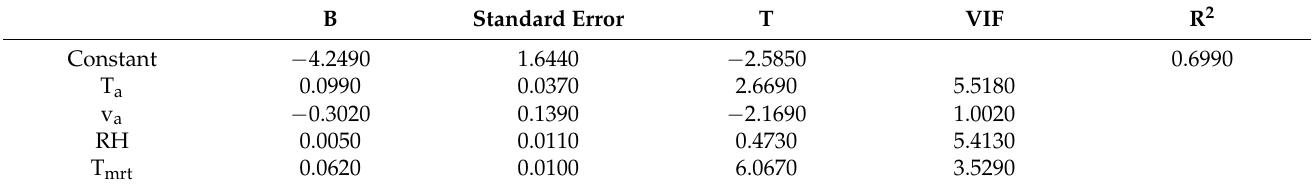
Table 4. Regression coefficient of the MTSV CQ